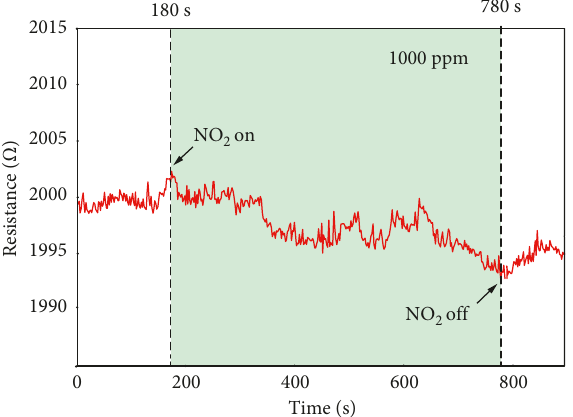
Figure 10: Resistance change of inkjet-printed MWCNT-PEDOT: PSS gas sensor exposed to 1000ppm NO 2 at room temperature.